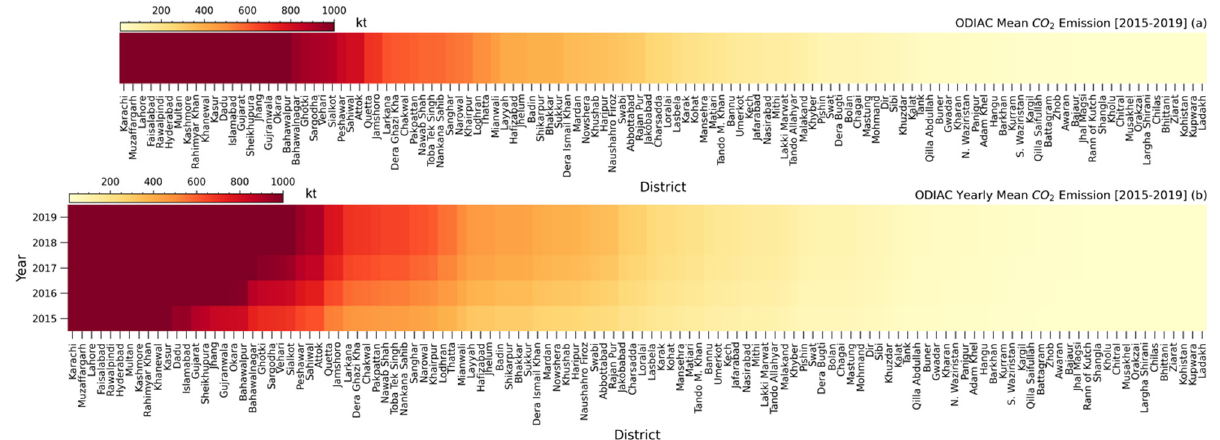
Figure 6. ( a ) Ranking of Pakistani districts based on mean anthropogenic CO 2 emissions and ( b ) mean annual anthropogenic CO 2 emissions for a period of five years from 2015 to 2019.